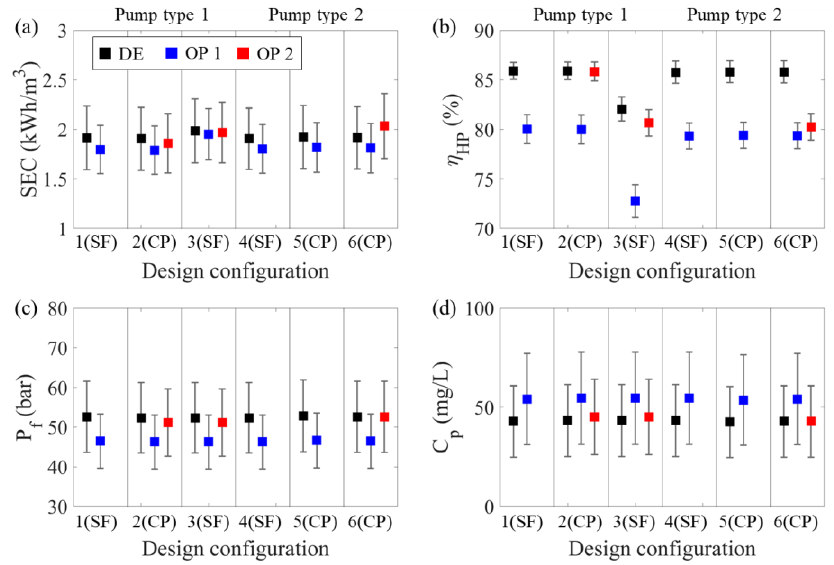
Figure 5. Operating performance according to design configuration and operation strategy: the annual statistics for ( a ) specific energy consumption (kWh/m 3 ), ( b ) pump efficiency, ( c ) operating pressure (bar), and ( d ) permeate TDS concentration (mg/L). The squares indicate the mean of each value. The error bars denote standard deviations above and below the mean values.